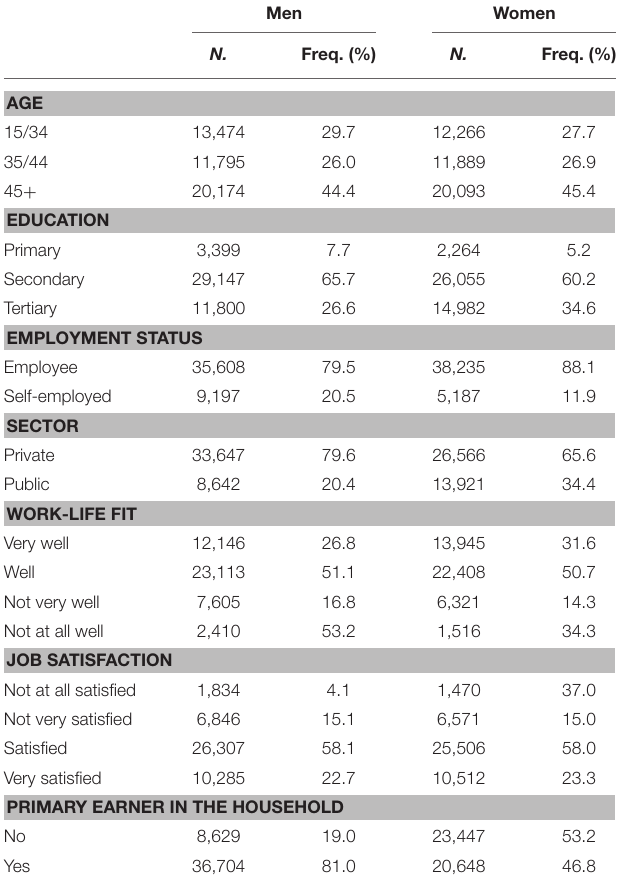
TABLE 1 | Summary statistics, by